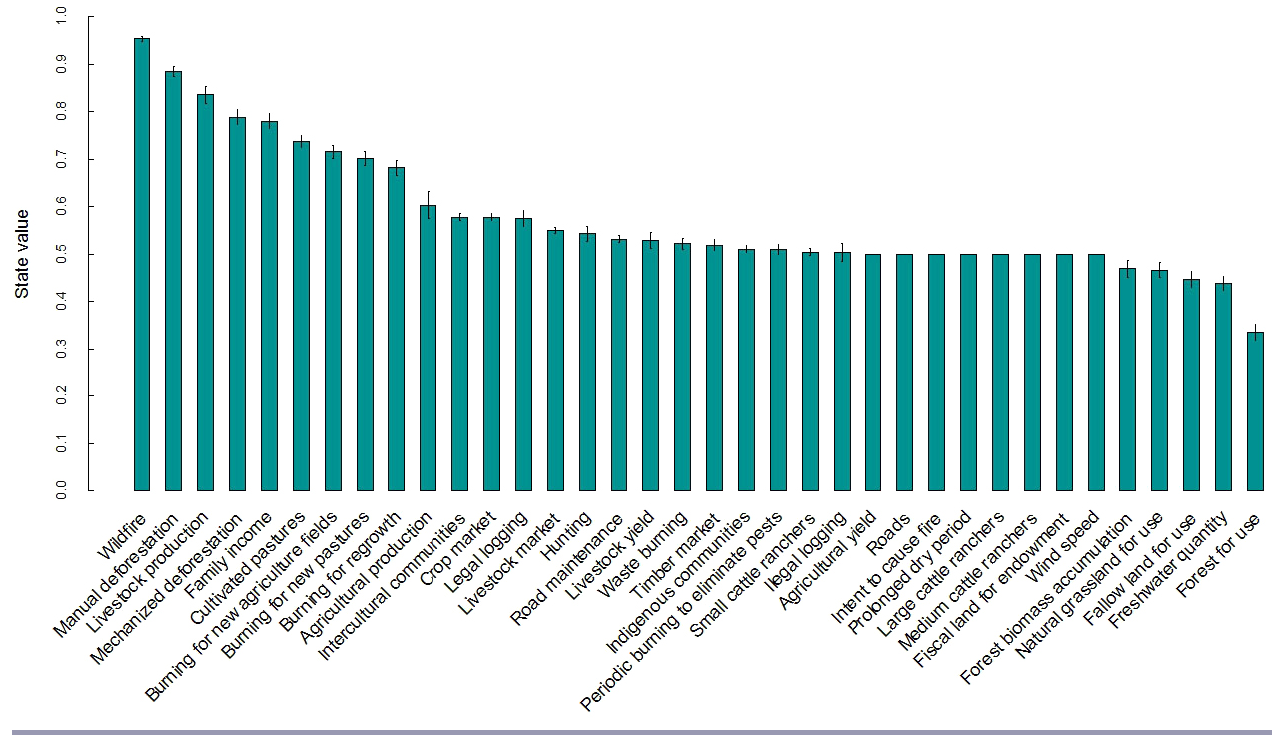
Fig. 5 . Bars show the baseline value of variables in the augmented fuzzy cognitive map (FCM) resulting from the inference produced based on current conditions. Baseline values could be interpreted as the influence/importance each variable has in the system from the combined perspective of the experts who participated in the FCM construction. The baseline is used as a reference to compare FCM inferences under different scenarios. Error bars represent uncertainty obtained by varying all the edge weights in the augmented FCM within 10% of their